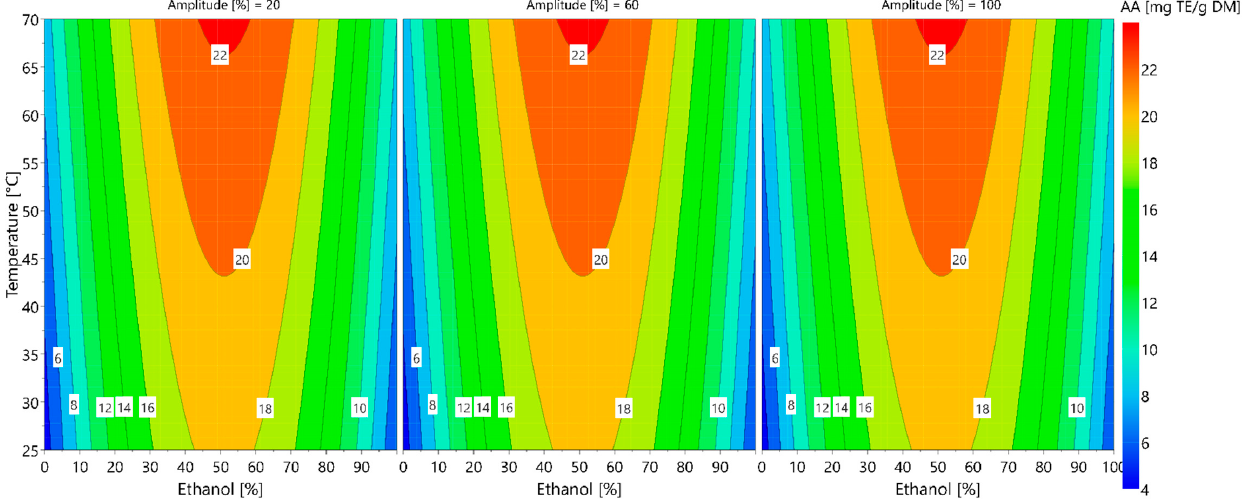
Figure 7. The 4D contour plots of the response, describing the antioxidant activity (AA) of the extract according to the extraction temperature, ethanol percentage and ultrasound amplitude.